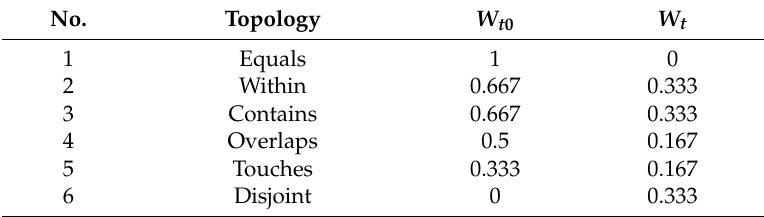
Table 2. The values of W t 0 and W t in different spatial topology